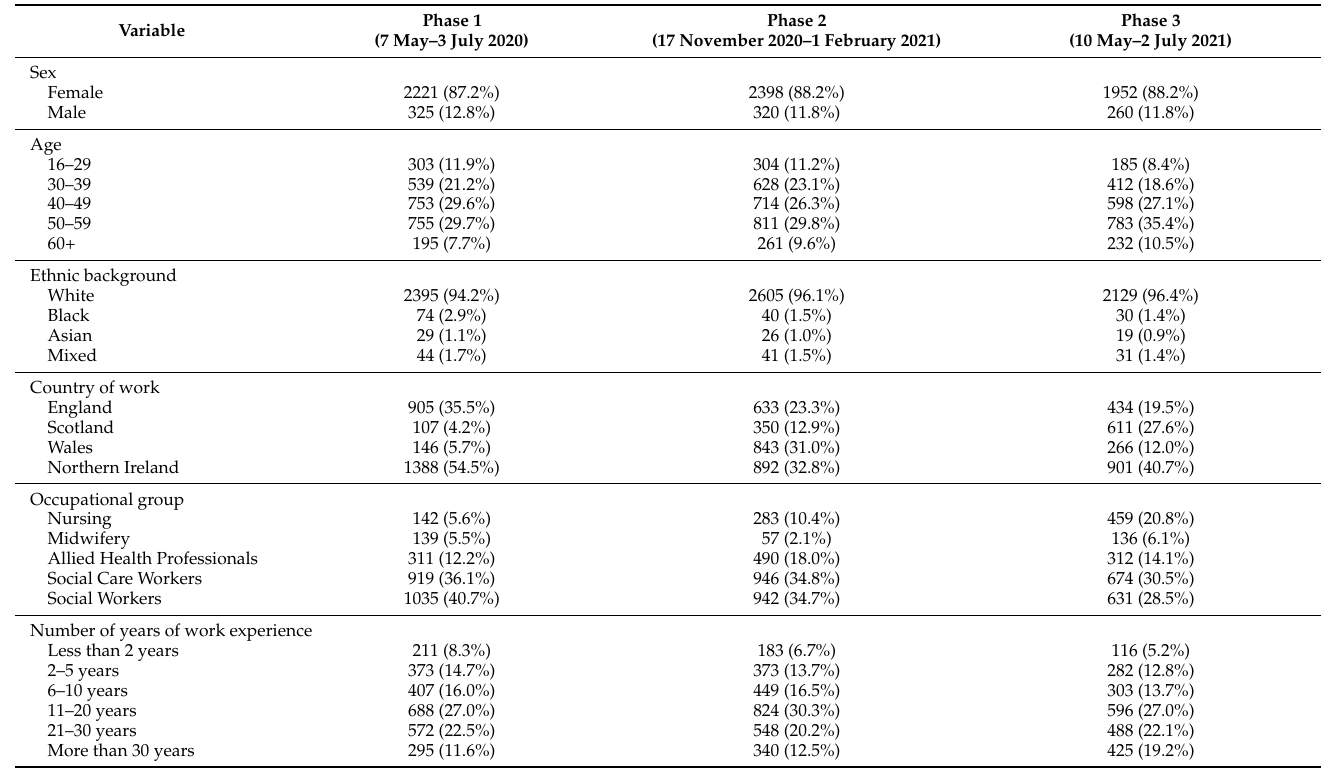
Table 1. Demographics and work-related characteristics of sample (Phase 1: n = 2546; Phase 2: n = 2718; Phase 3: n =